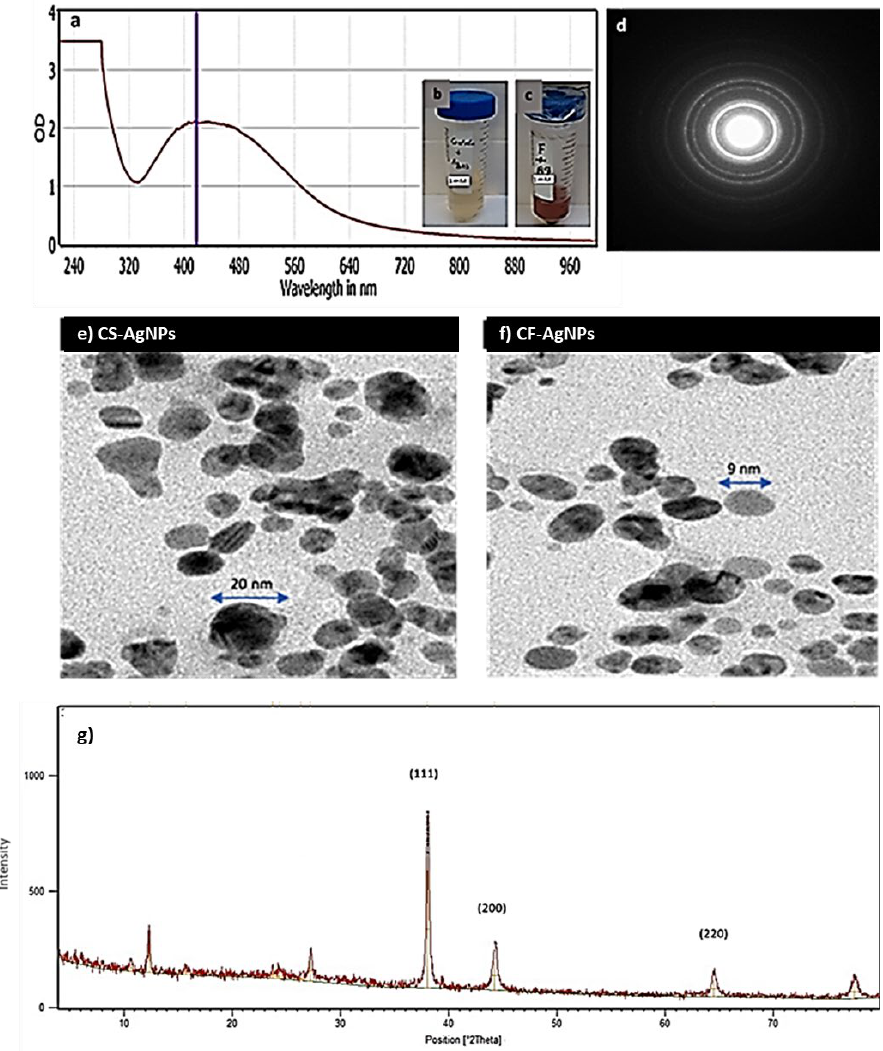
Figure 3. ( a ) Surface plasmon absorption bands (SPR) of AgNPs formed in the presence of Strepto- myces sp. ASM23 cell filtrate (CF-AgNPs). ( b ) The color change due to the reduction of metal ions and ( c ) the formation of AgNPs represented by ( a ) Control+ AgNO3 and ( b ) Streptomyces sp. ASM23 cell filtrate+ AgNO 3 . ( d ) Selected area (electron) diffraction (SAED) confirms the crystalization of nanoparticles. ( e ) Transmission electron microscope micrographs for ( f ) AgNPs biosynthesized by Streptomyces sp. ASM23 cell filtrate (CF-AgNPs) and cell supernatant (CS-AgNPs). ( g ) X-ray diffraction (XRD) pattern of silver nanoparticles.